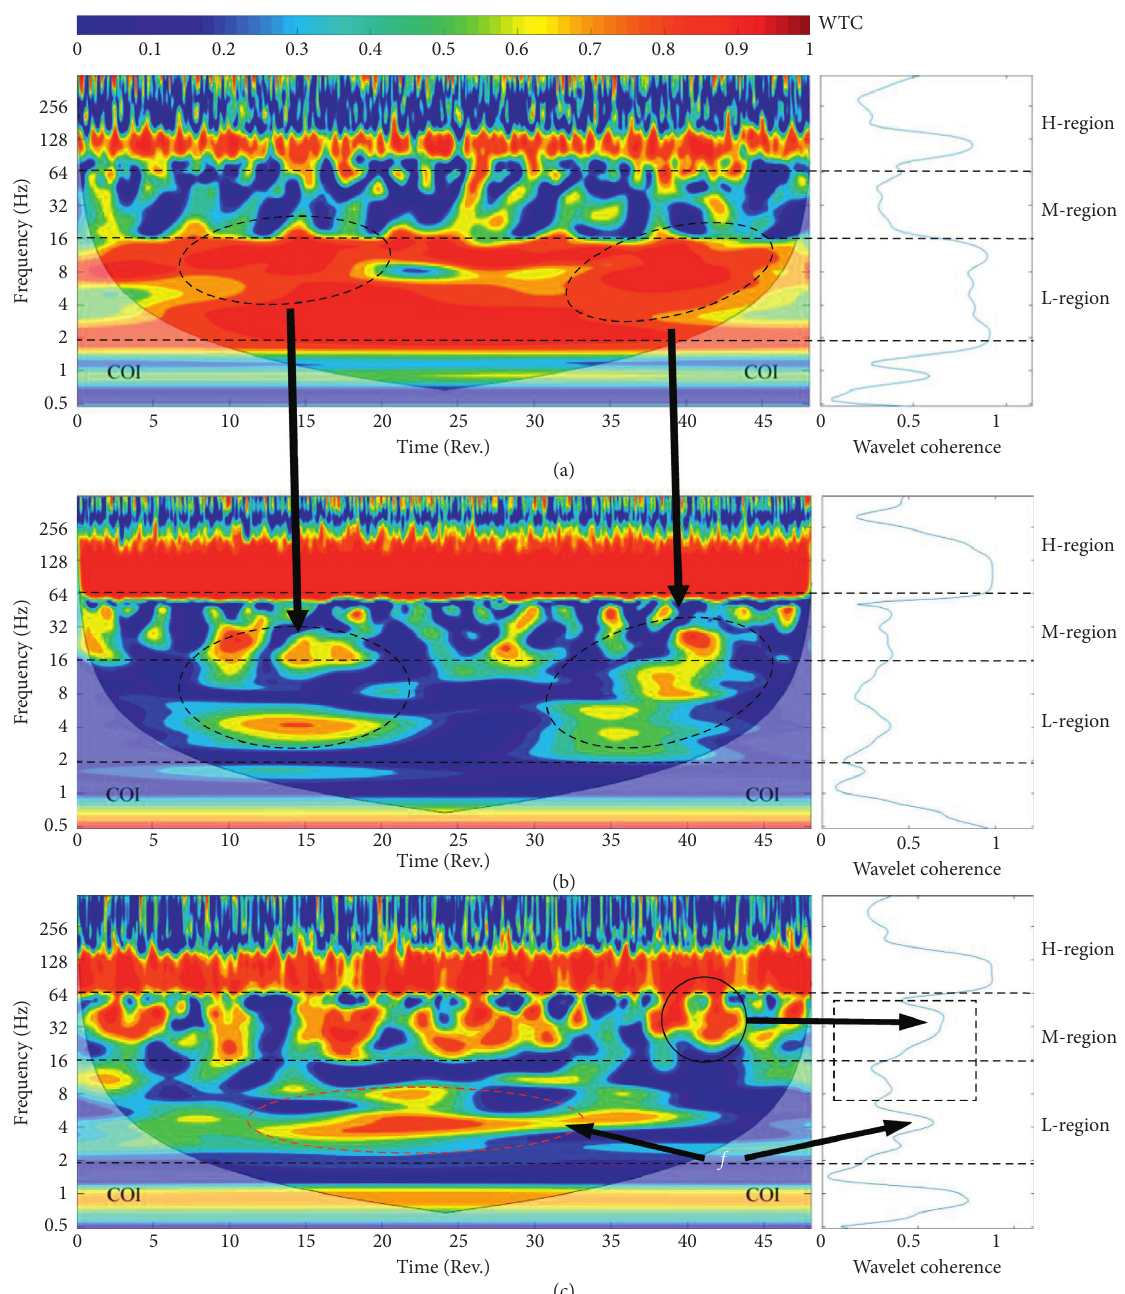
Figure 11: Wavelet coherence spectrum of pressure pulsation of axisymmetrical pressure sensors with different tip clearances. (a) Impeller inlet. (b) Impeller middle. (c) Impeller